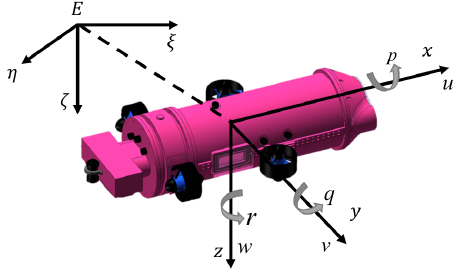
Figure 2. Coordinate frame of the